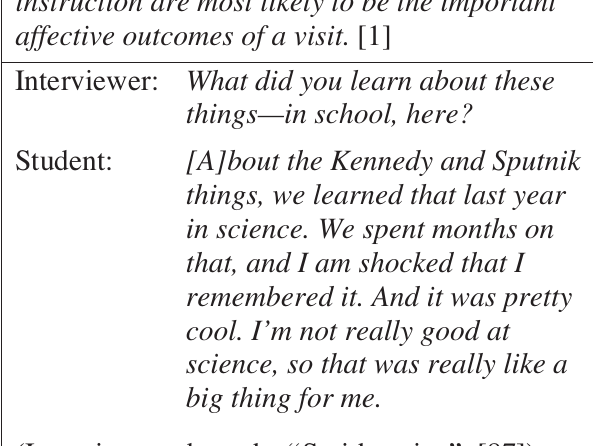
FIG. 2. Connecting learning in and out of school: high potential of OSLOs as “ catch ” events (top) and for positive affective impact of “ experience of competence ”